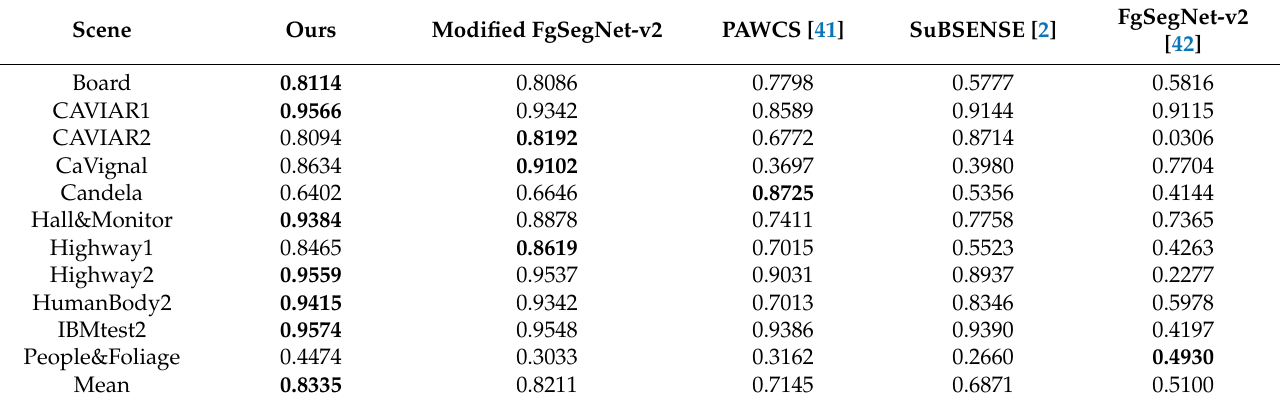
Table 8. Comparison of FM score by the proposed method and other algorithms on the SBI2015